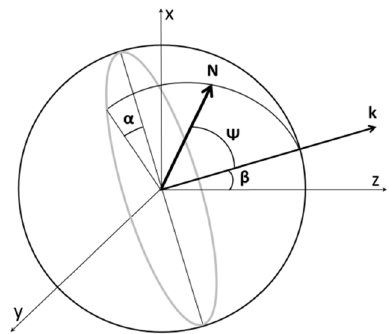
Figure 1. Scattering geometry. Direction N denotes the orientation of the symmetry axis of the particle, and k represents the direction of wave propagation (which is perpendicular to the polarization plane and lies in the x, z plane). The polarization plane is depicted by the grey ellipse. The x axis is true vertical, and y and z are the orthogonal horizontal directions. The canting angle α is the angle between the projections of vector N and true vertical x on the polarization plane, ψ is the angle between N and k , and the antenna elevation is β